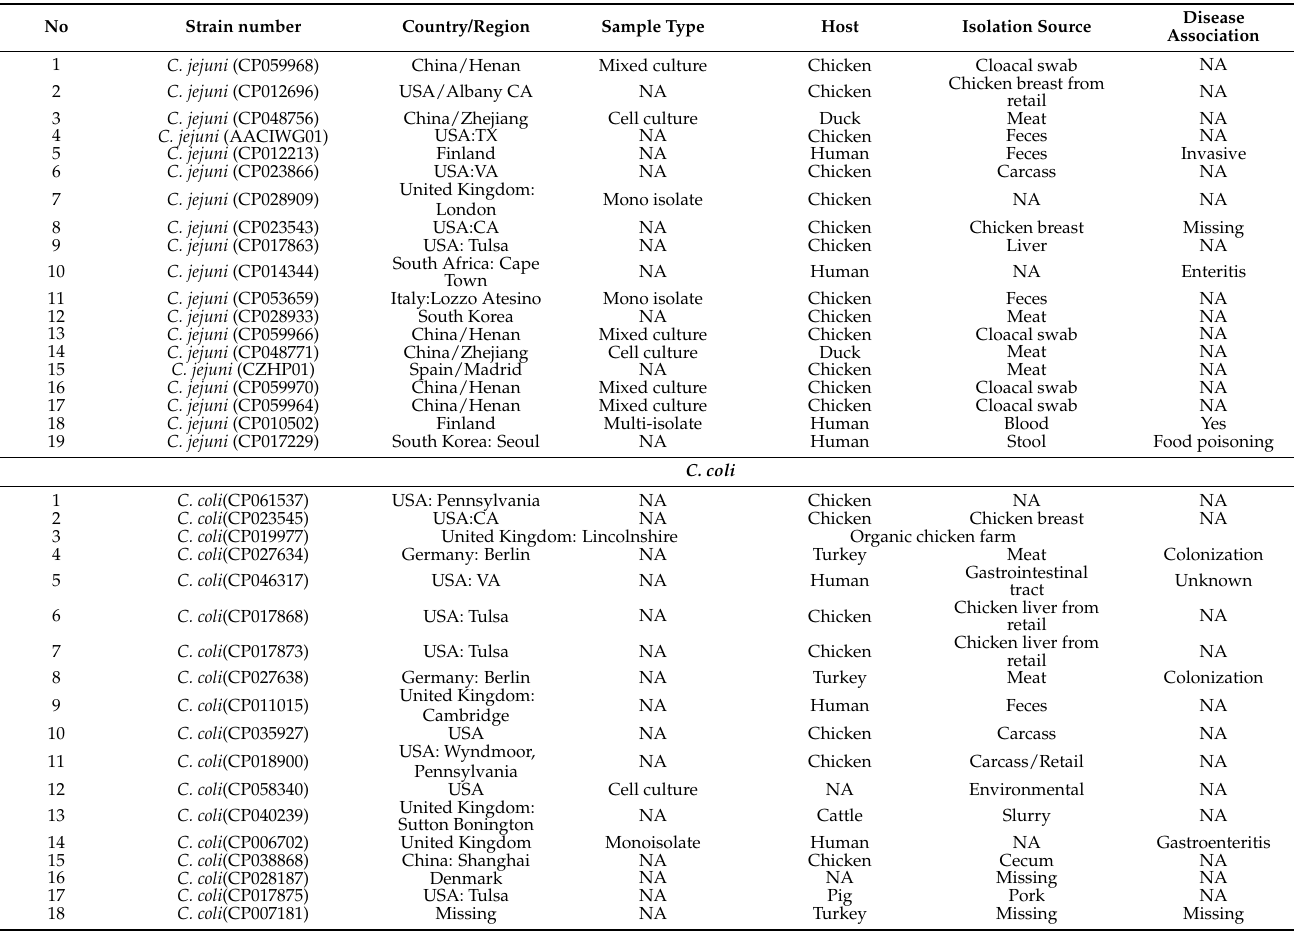
Table 2. Genomic features of strains submitted to the TYGS